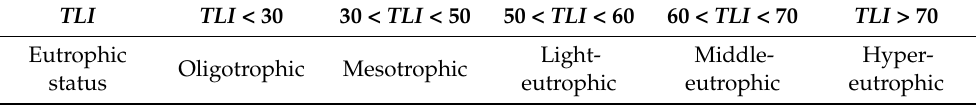
Table 2. Trophic Level Index ( TLI ) value ranges and corresponding trophic status for Chinese lakes. TLI TLI < 30 30 < TLI < 50 50 < TLI < 60 60 < TLI < 70 TLI > 70 Eutrophic Middle- eutrophic